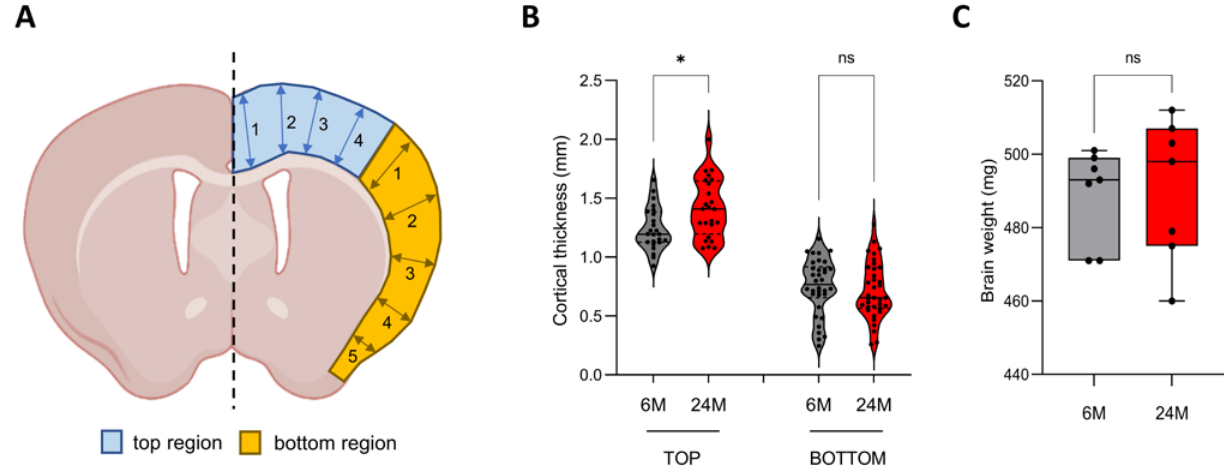
Figure 1. Anatomical characteristics of the aging brain. ( A ) Schematic depicting a coronal brain cut, with the two areas where cortical thickness was measured. The blue area represents the “top” of the cerebral cortex, comprising the anterior cingulate area, the motor area and the primary somatosensory area (limbs). The orange area represents the “bottom” of the cerebral cortex, with the supplemental somatosensory area (barrel and nose), the visceral area, the gustatory area and the piriform area. The thickness of the top and bottom areas was measured at different locations, as indicated by numbered arrows. ( B ) Coronal cuts of the whole brain of 6- and 24-month-old mice (respectively grey and red; n = 6 per age group; 3 males and 3 females) were stained with hematoxylin and eosin, and the thickness of the top and bottom areas was measured. (*) p < 0.0001 in one-way ANOVA; ns: not significant. ( C ) Graph representing the wet weight of the brain after dissection (n = 6 per age group; 3 males and 3 females). ns: not significant from unpaired t-test with equal means.